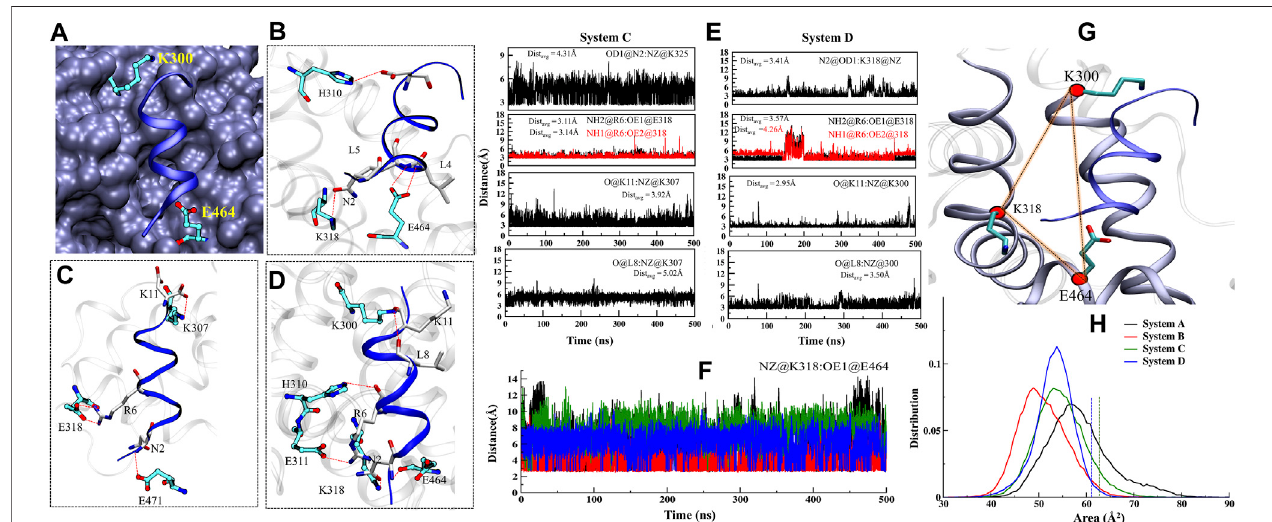
FIGURE 8 | Dynamics analysis of the ‘ co-activator ’ binding pocket. (A) The view of “ charge clamp ” K300/307 (H3) and E464/471 (H12) in the stabilization of AF2 (blue)instructure andinteractswiththe ‘ co-activator ’ . (B) Theinteractingresiduesinthebindingsite ofthe ‘ co-activator ’ inFXRcrystal. (C,D) Theinteractingresiduesof the FXR stable MD state of System C and D. (E) The depiction of the HB durance throughout MD simulation. (F) The time series plot of distance between the NZ@K318 with OE2@E464 throughout MD simulations. (G) The panel represents the area between the residues K300, K318 and E464. Beads (red color) correspond to the